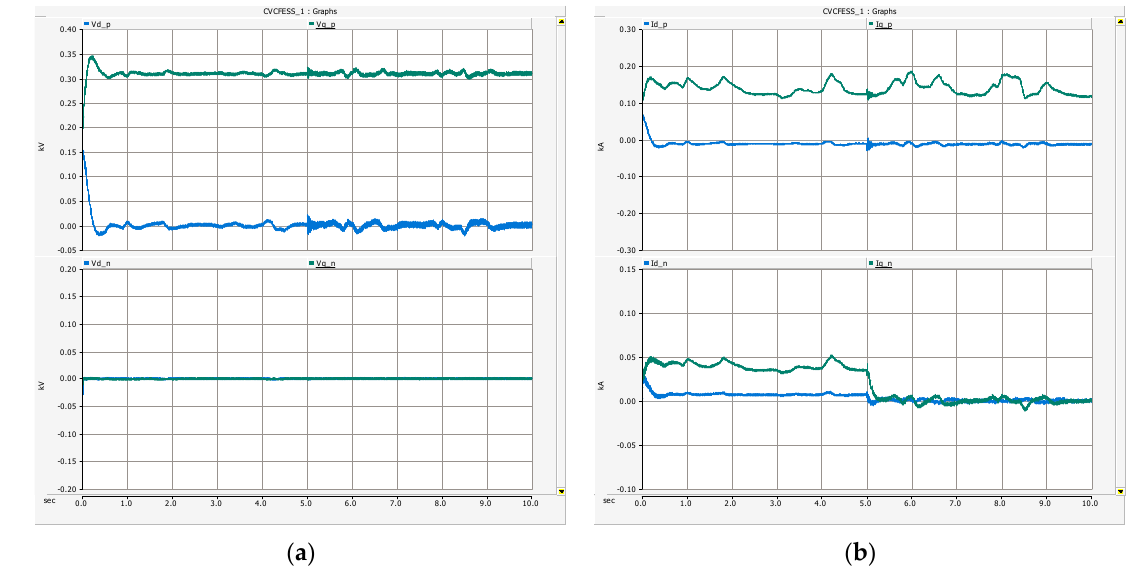
Figure 17. Simulation results of Scenario 2 ( a ) mBESS (top: dq-axis PSV; bottom: dq-axis NSV) and ( b ) mBESS (top: dq-axis PSC; bottom: dq-axis NSC).